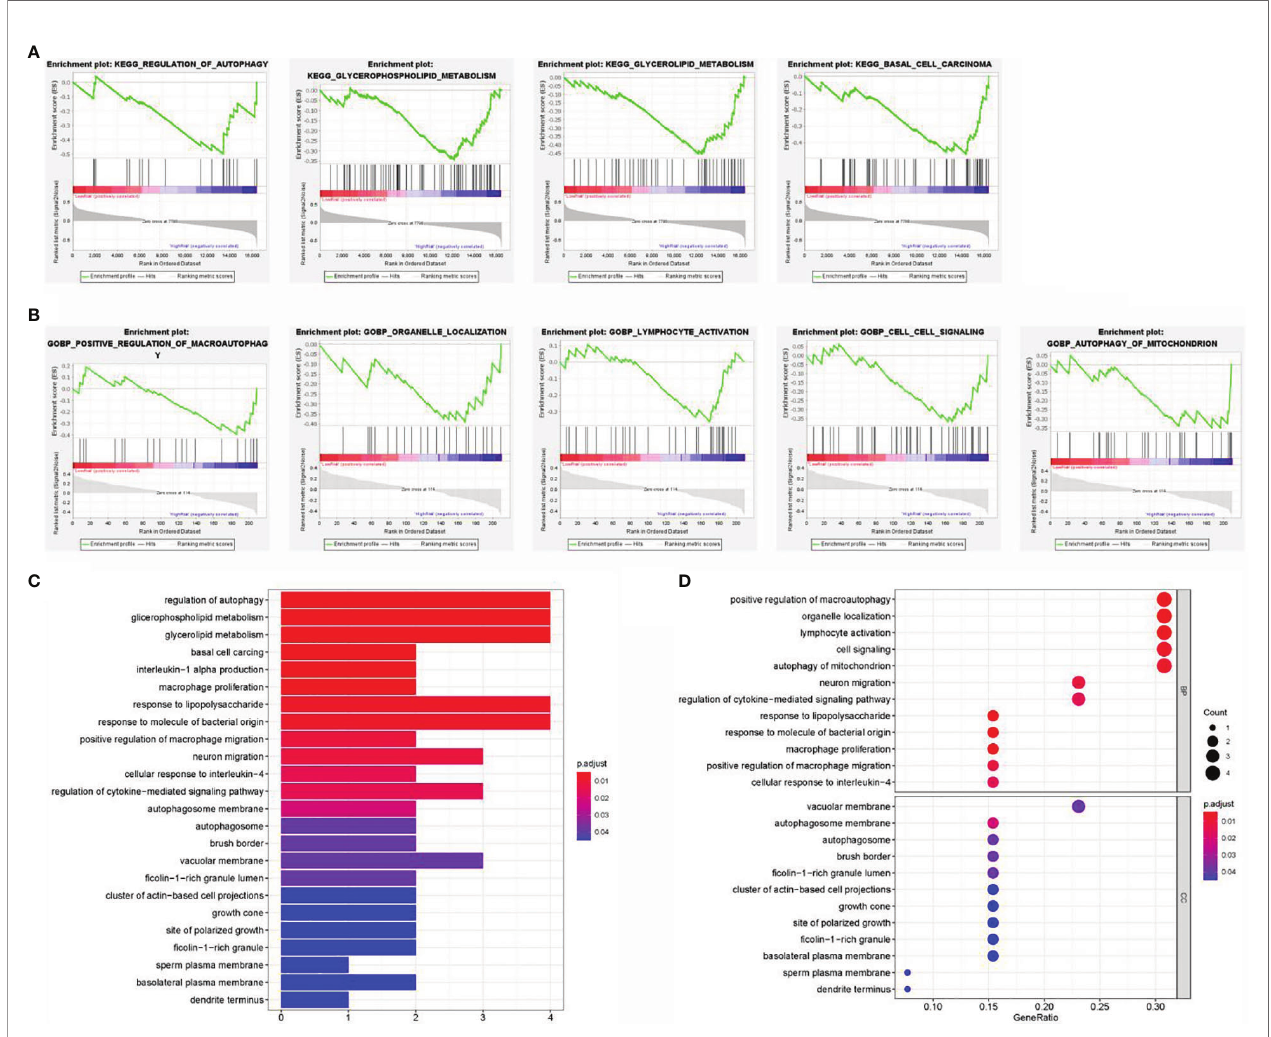
FIGURE 8 | Gene set enrichment analysis (GSEA) of the high- and low-risk groups. (A) Enrichment analysis of KEGG pathway. (B) Enrichment analysis of GO pathway. (C) Barplot graph for KEGG pathways. (D) Bubble graph for GO